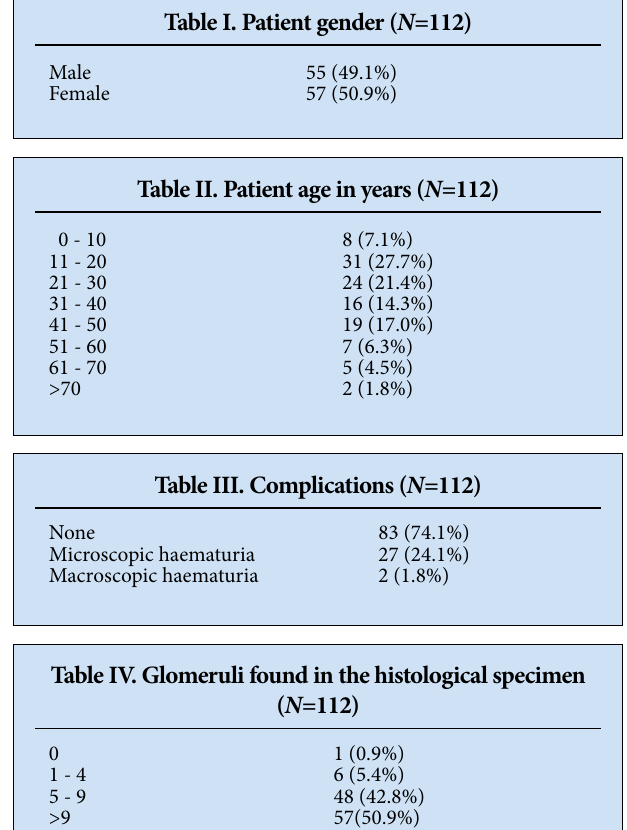
Table I. Patient gender ( N= 112)